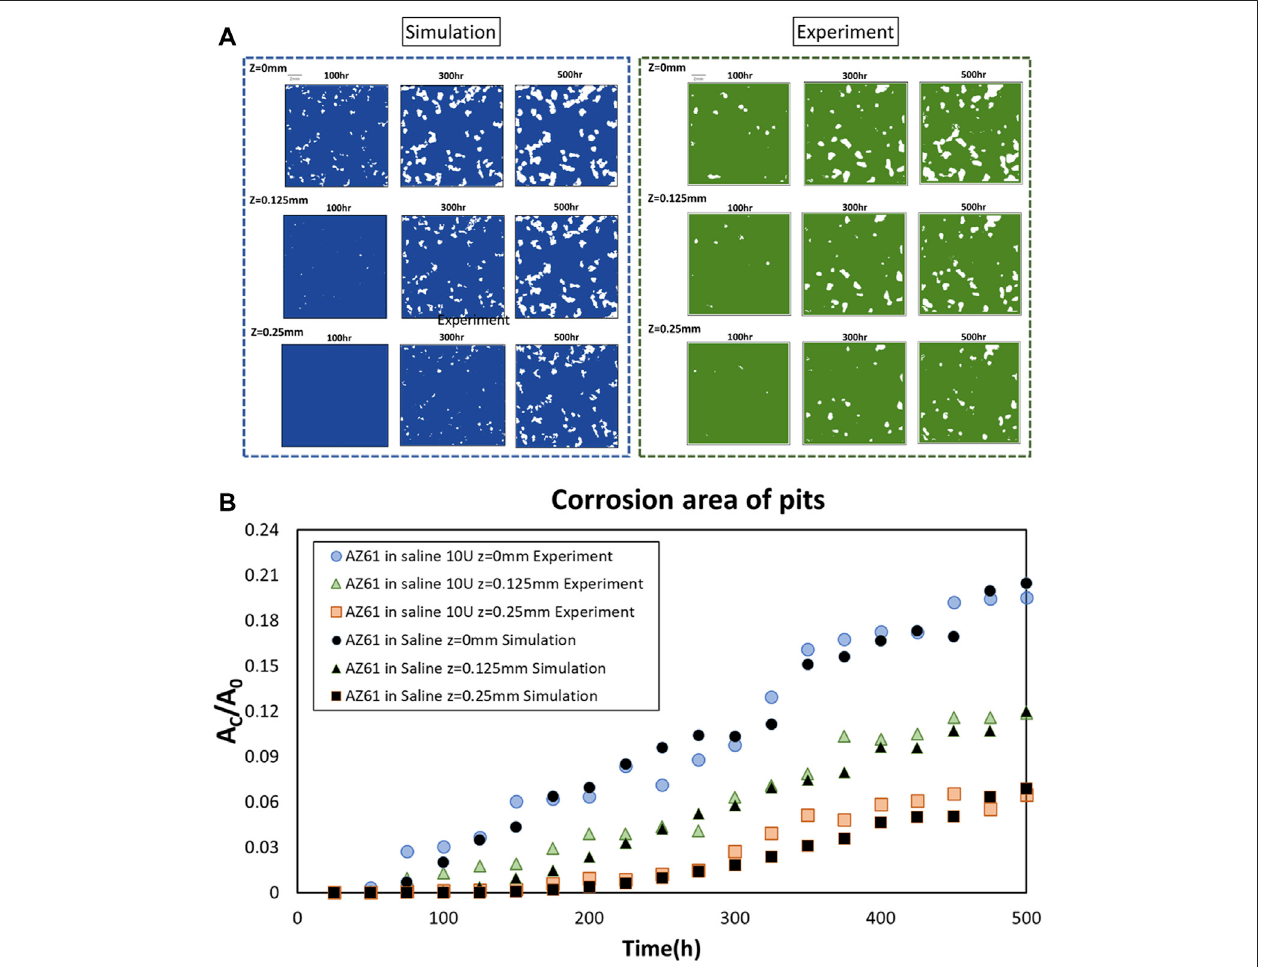
FIGURE 3 | Comparison of experimental and simulated horizontal cross sections. (A) Comparison of experimental and simulated corrosion patterns across three parallel cross sections at z = 0, 0.125, and 0.25 mm at T = 100, 300, and 500 h, respectively. (B) Projected corrosion area A C on three planes at z = 0, 0.125, and 0.25